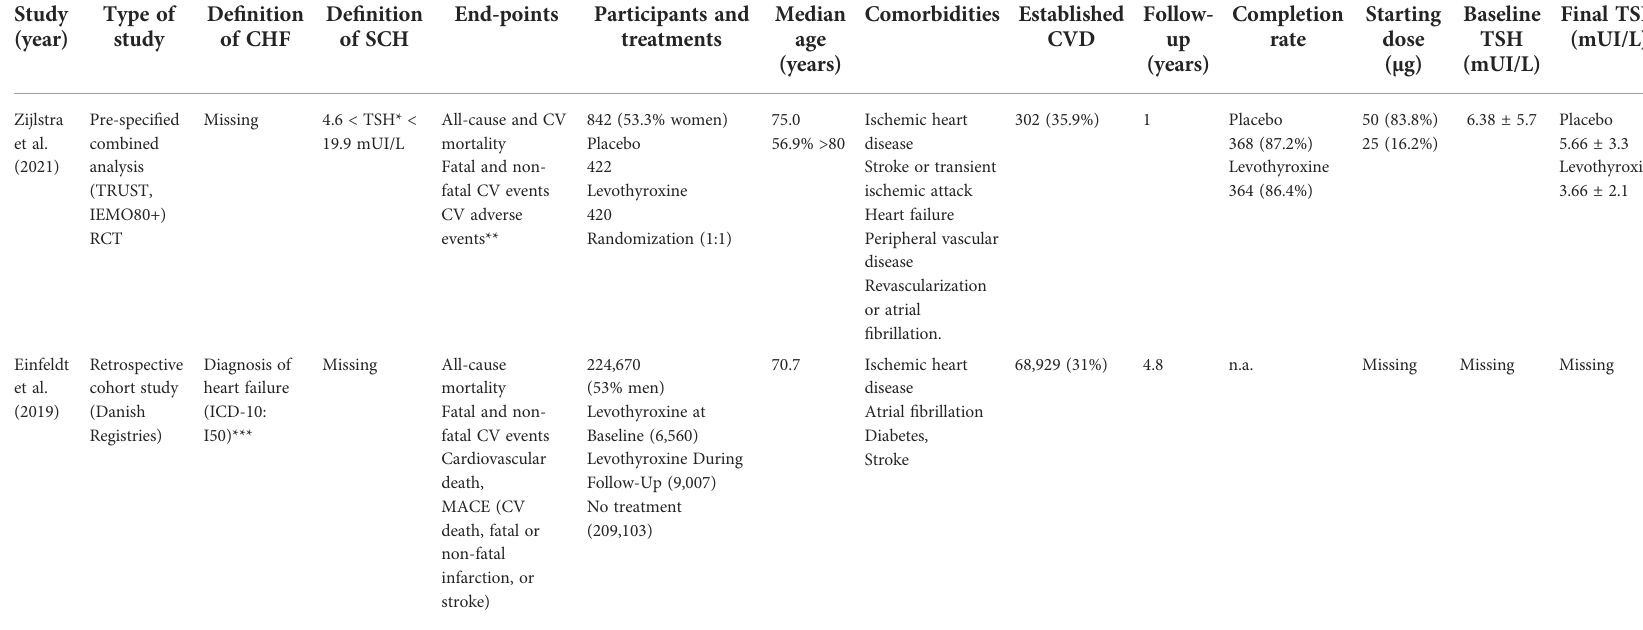
TABLE 2 Summary of included studies ’